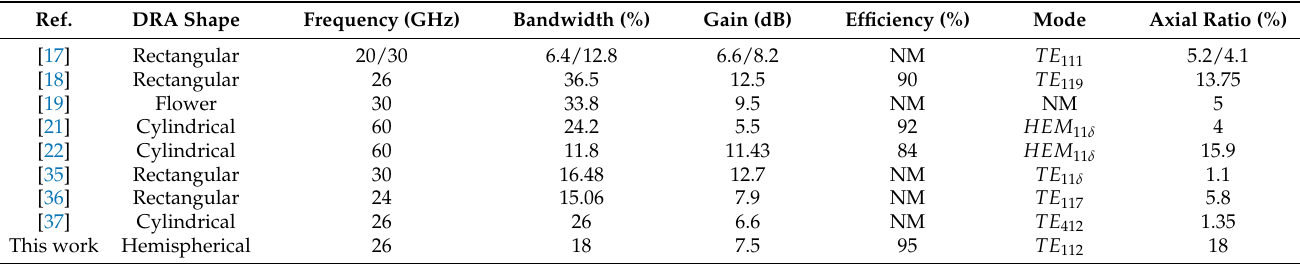
Figure 22. Radiation pattern of the integrated hemispherical DRA with perforated substrate excited in the TE 112 mode at 26 GHz ( a ) φ = 0 ◦ ( b ) φ = 90 ◦ . The presented CP HDRA’s performance parameters, bandwidth, gain, efficiency, mode and AR, are listed in Table 1 and compared to those of different mmWave CP DRA configurations that have been reported in the literature. The proposed approach provides a wider AR bandwidth compared to those in the reported studies. Table 1. Comparison between the performance of circularly polarized